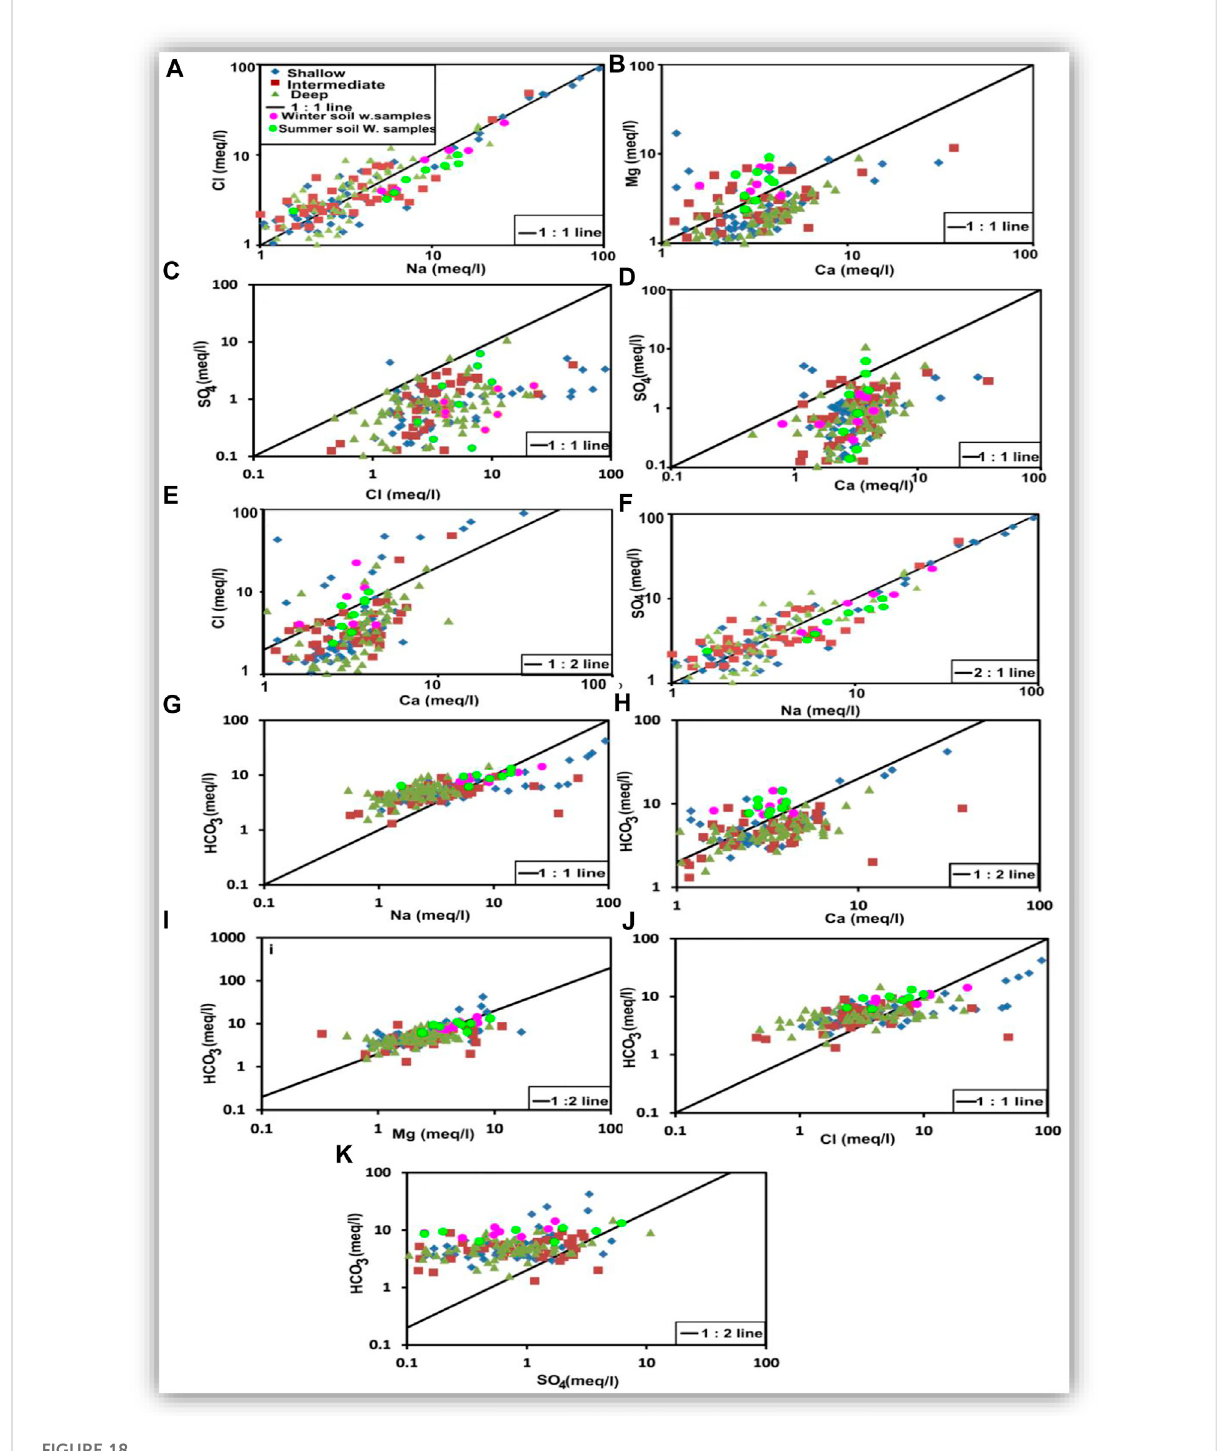
FIGURE 18 Ionic relationships to estimate the hydrogeochemical processes that occur in the groundwater.